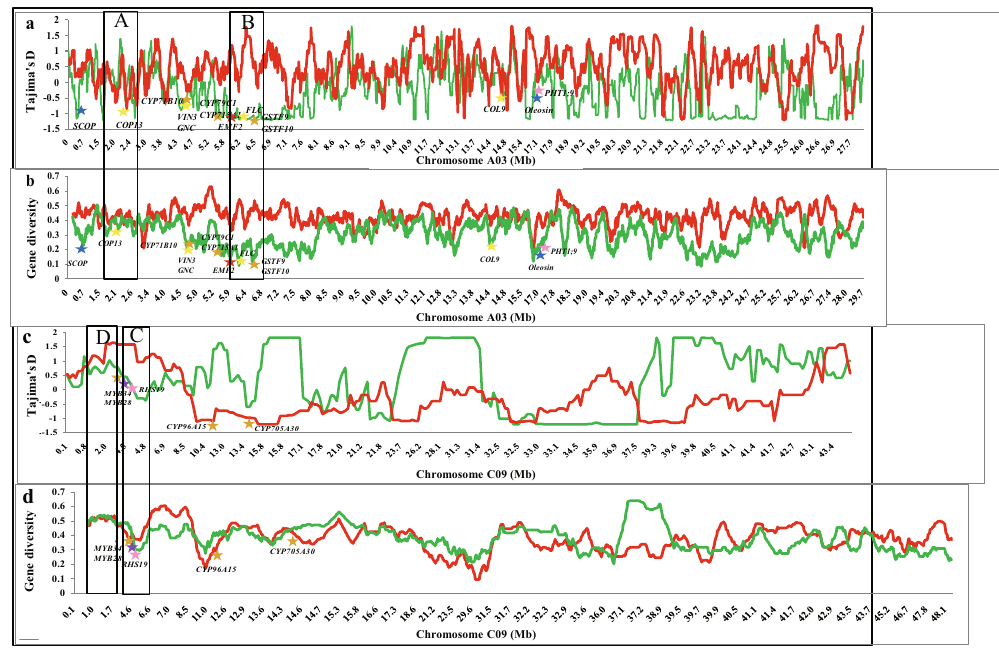
Figure 5. Variation in Tajima’s D ( a,c ) and gene diversity ( b,d ) values across chromosome A03 ( a,b ) and chromosome C09 ( c,d ) for cultivars in the Tapidor (red) and Ningyou7 (green) pedigrees. Key genes controlling flowering time (yellow stars), seed oil content (blue stars), seed glucosinolate content (orange star), seed erucic acid content (red stars), seed protein content (purple stars), and root morphological traits (pink stars) are indicated. Examples of genes in regions with Tajima’s D < 0 and gene diversity > 0.3, implying early selection during the breeding process (Box A), in regions with Tajima’s D < 0 and gene diversity < 0.3, implying later selection in the breeding process (Box B), in regions with Tajima’s D > 0 and gene diversity < 0.3, indicating selection before the pedigrees shown here (Box C), and in regions with Tajima’s D > 0 and gene diversity > 0.3, implying no selection on the locus (Box D), are